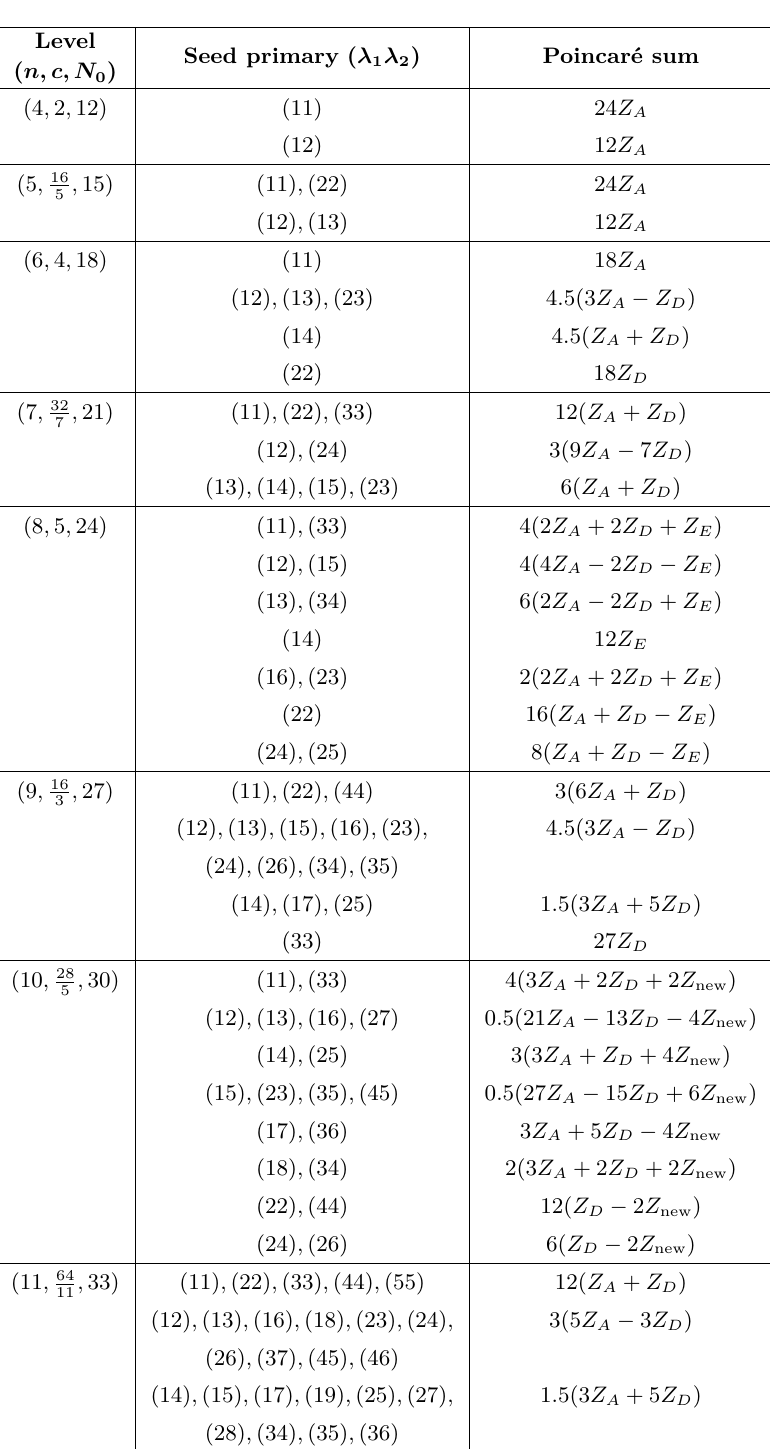
Table 6. Poincaré sums for SU(3) k